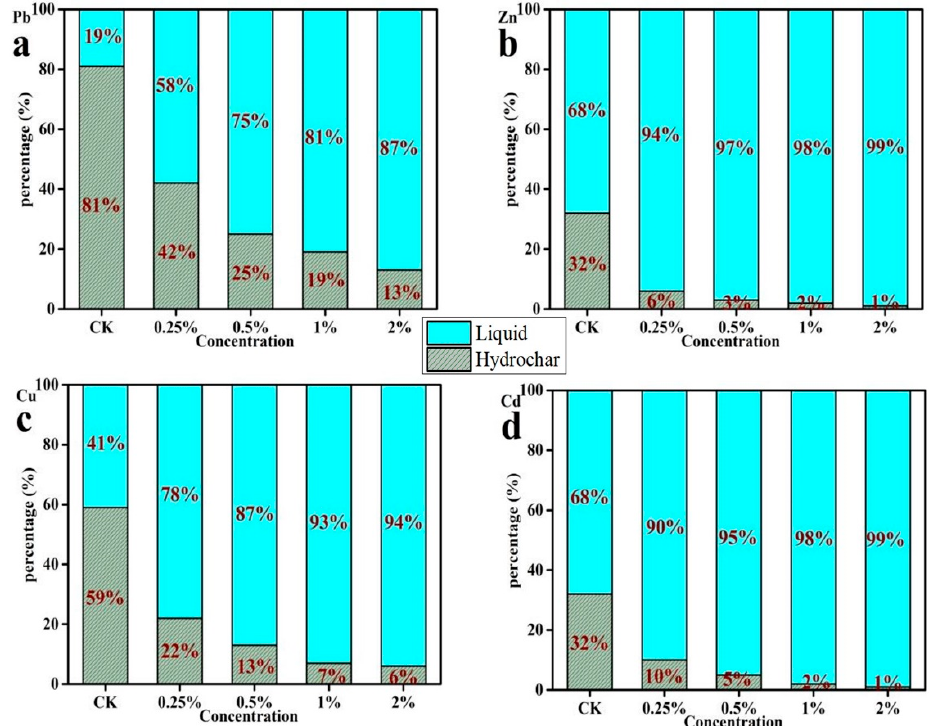
Figure 3. Heavy metal fractions in liquid and hydrochar formed in different HCl concentrations at 200 °C. Pb ( a ), Zn ( b ), Cu ( c ), Cd ( d ). 200 ◦ C. Pb ( a ), Zn ( b ), Cu ( c ), Cd ( d